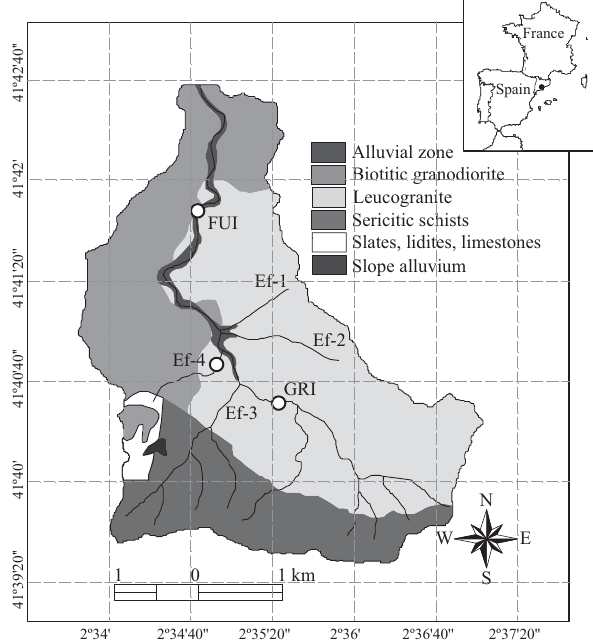
Fig. 1. Lithological units in the Fuirosos Stream Watershed (Montnegre-Corredor Natural Park, NE Spain) (sensu IGME, 1983). There is an identifiable alluvial zone at the valley bottom. Circles indicate the sampling stations located at the valley-bottom catchment (FUI, 10.5km 2 ) and at the hillslope catchments Grimola (GRI, 3.5km 2 ) and Ef-4 (0.3km 2 ).